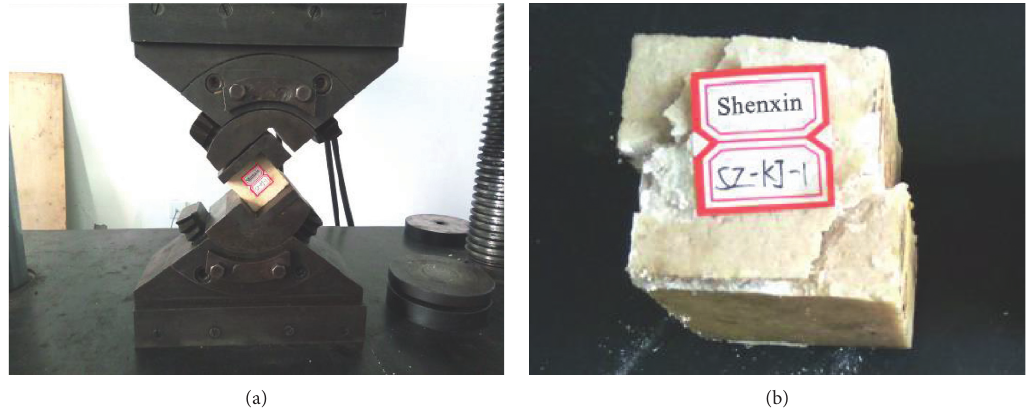
Figure 11: Shear test process and failure specimen. (a) Specimen installation. (b) Shear angle 58